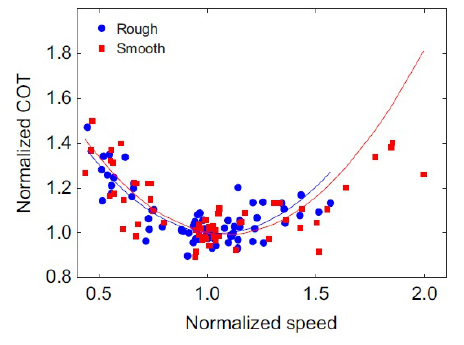
Fig. 2 Limb movement trajectories of subjects of different heights walking at a fixed